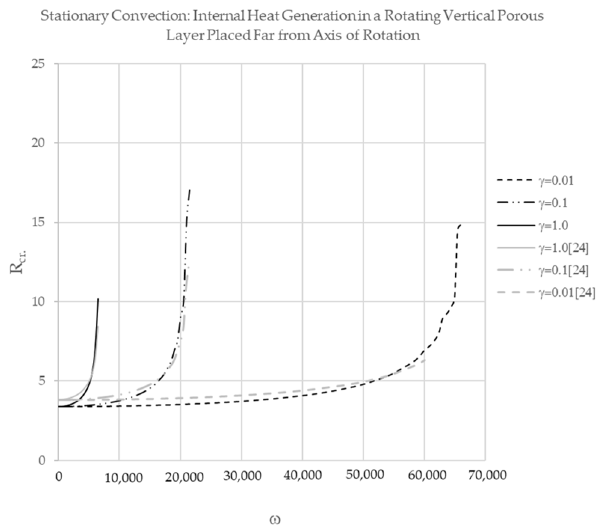
Figure 5. Critical Rayleigh number versus vibration frequency for selected values of Vadasz number for a vertical porous layer placed far away from the axis of rotation (black lines). The results for the non-rotating horizontal porous layer with internal heat generation [24] (gray lines) superimposed.